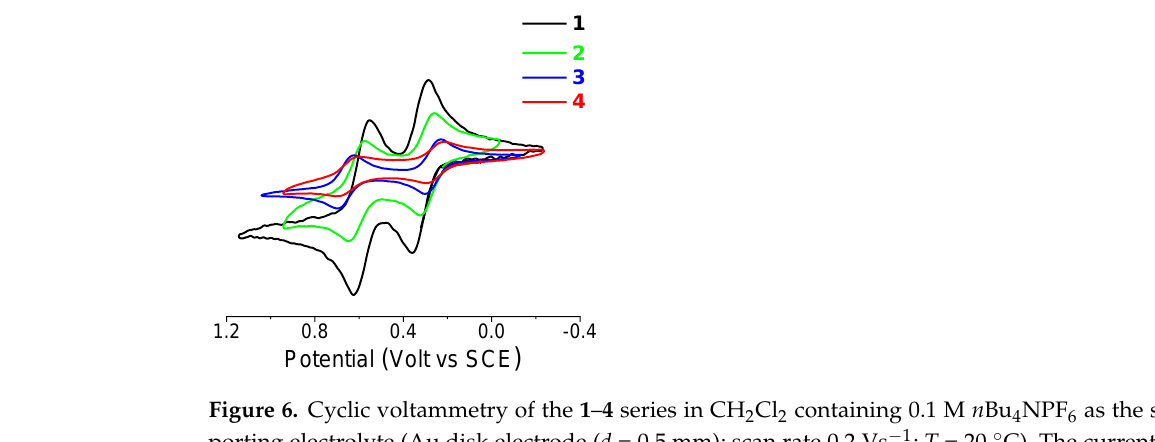
n r e s i due Figure 8. Comparison of variation in oxidation potential of L -Dap(Boc) (red), Aib (green) and Δ Ala (blue) bis-ferrocenyl end-capped peptides. The data are normalized to the potentials of 1 . Mainly, it appears that in the 3 10 -helical homopeptides of L -Dap(Boc) and Aib amino acids, characterized by active dipole moments, an important and continuous variation of E 1/2 occurs as the peptide length is increased, positive and negative depending on the ori- entation of the peptide dipole moment with respect to Fc. On the contrary, Δ Ala homo- peptides, adopting the fully extended conformation (2.0 5 -helix) [66,67], have no dipole moment, and consequently, the terminal Fcs show negligible variations of their E 1/2 . In addition, while the oxidation potential of the C-terminal Fc in the L -Dap(Boc) and Aib series decreases with the elongation of the peptide chain, displaying almost identical slopes (d E 1/2 /d n = 22 ± 4 and 23 ± 3 mV), the potential of the N-terminal Fc increases more rapidly for the L -Dap(Boc) (d E 1/2 /d n = 27 ± 6 mV) than that of the (Aib) n homopeptides (d E 1/2 /d n = 8 ± 1 mV). This result is rather surprising as it seems to suggest that L -Dap(Boc)